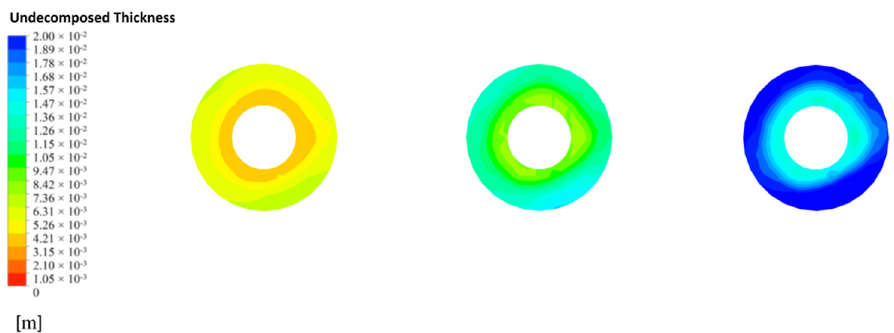
Figure 21. Variation of 40 mm, 80 mm and 120 mm undecomposed thickness of CaO outlet.